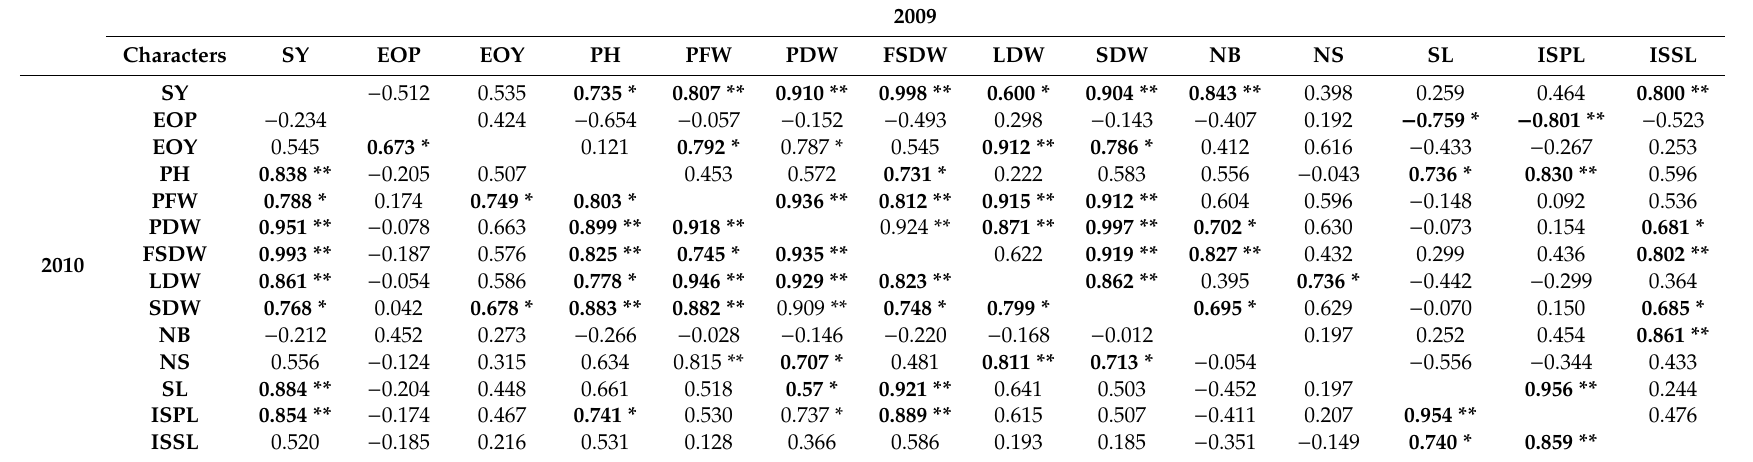
Table 8. Correlation matrix of the main biometric and production